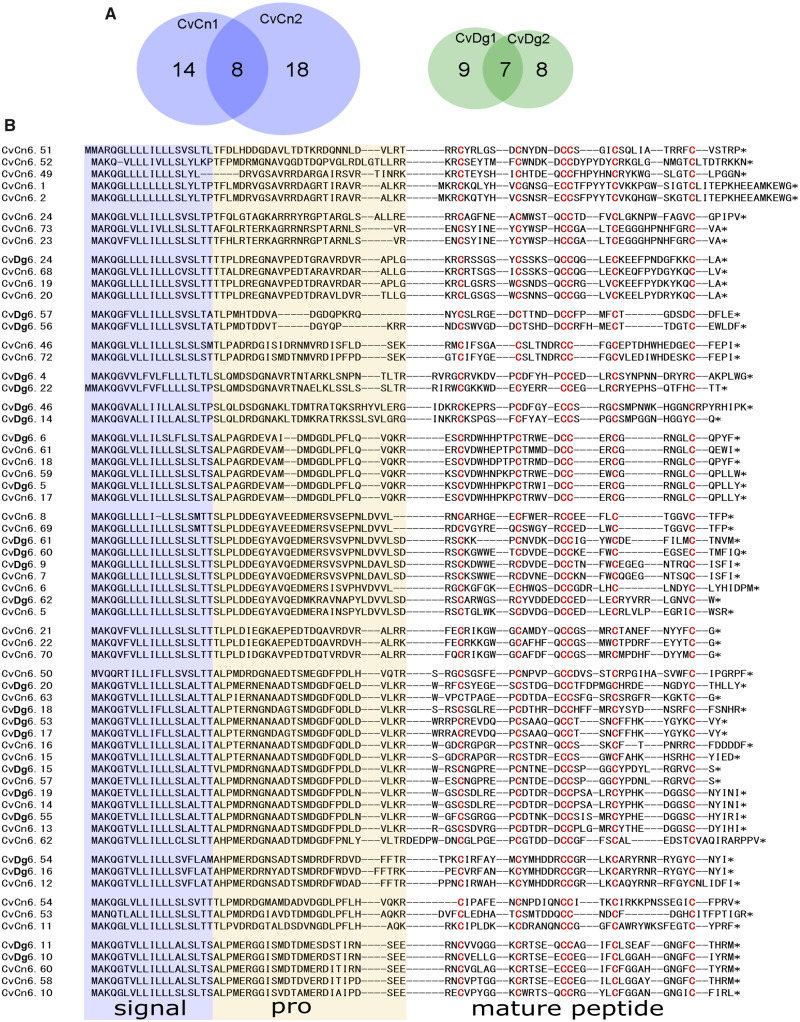
—Diversity of the predicted toxins in the drillipeptide superfamily 7. (A) Venn diagram of the drillipeptide diversity in studied specimens of Clavus. (B) Alignment of 64 predicted complete precursors.